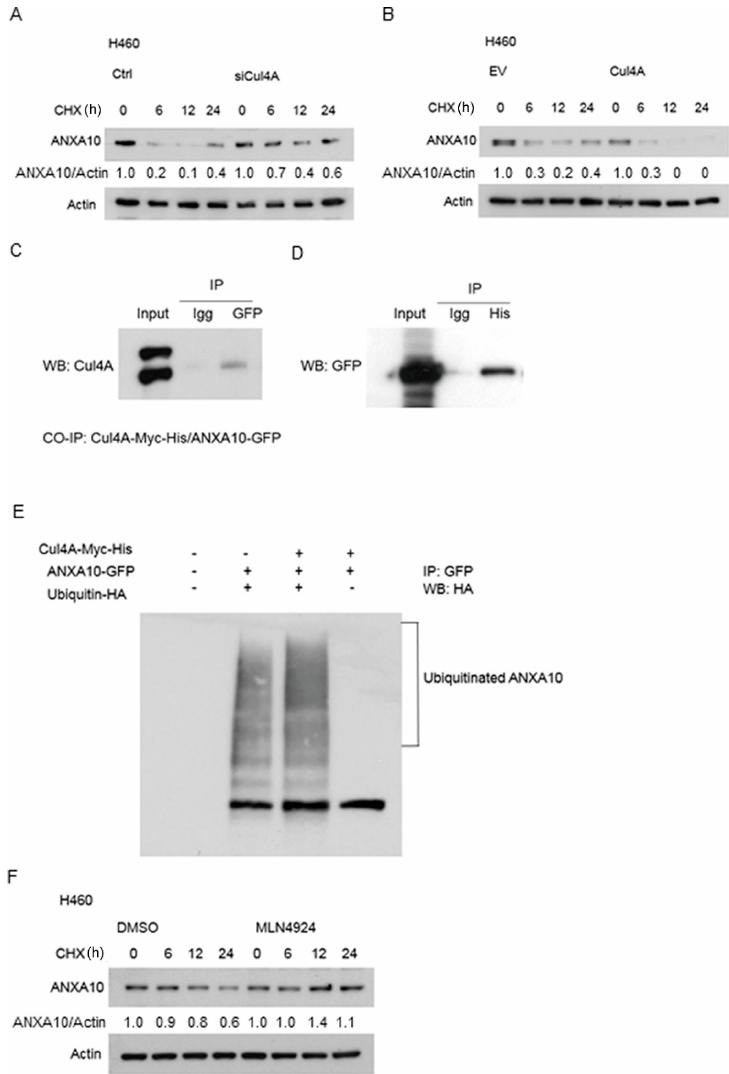
Figure 6. ANXA10 is ubiquitinated by Cul4A through a protein–protein interaction stimulating degradation. ( A ) Protein degradation assay for ANXA10 in the H460 lung cancer cells. H460 lung cancer cells were transfected with Cul4A siRNA (siCul4A) or control siRNA (ctrl). ( B ) Protein degradationassayforANXA10intheH460lungcancercells. H460lungcancercellsweretransfectedand overexpressed with pcDNA3-Myc3-CUL4A (Cul4A) or empty pcDNA3.1 vector (EV). H460 cells